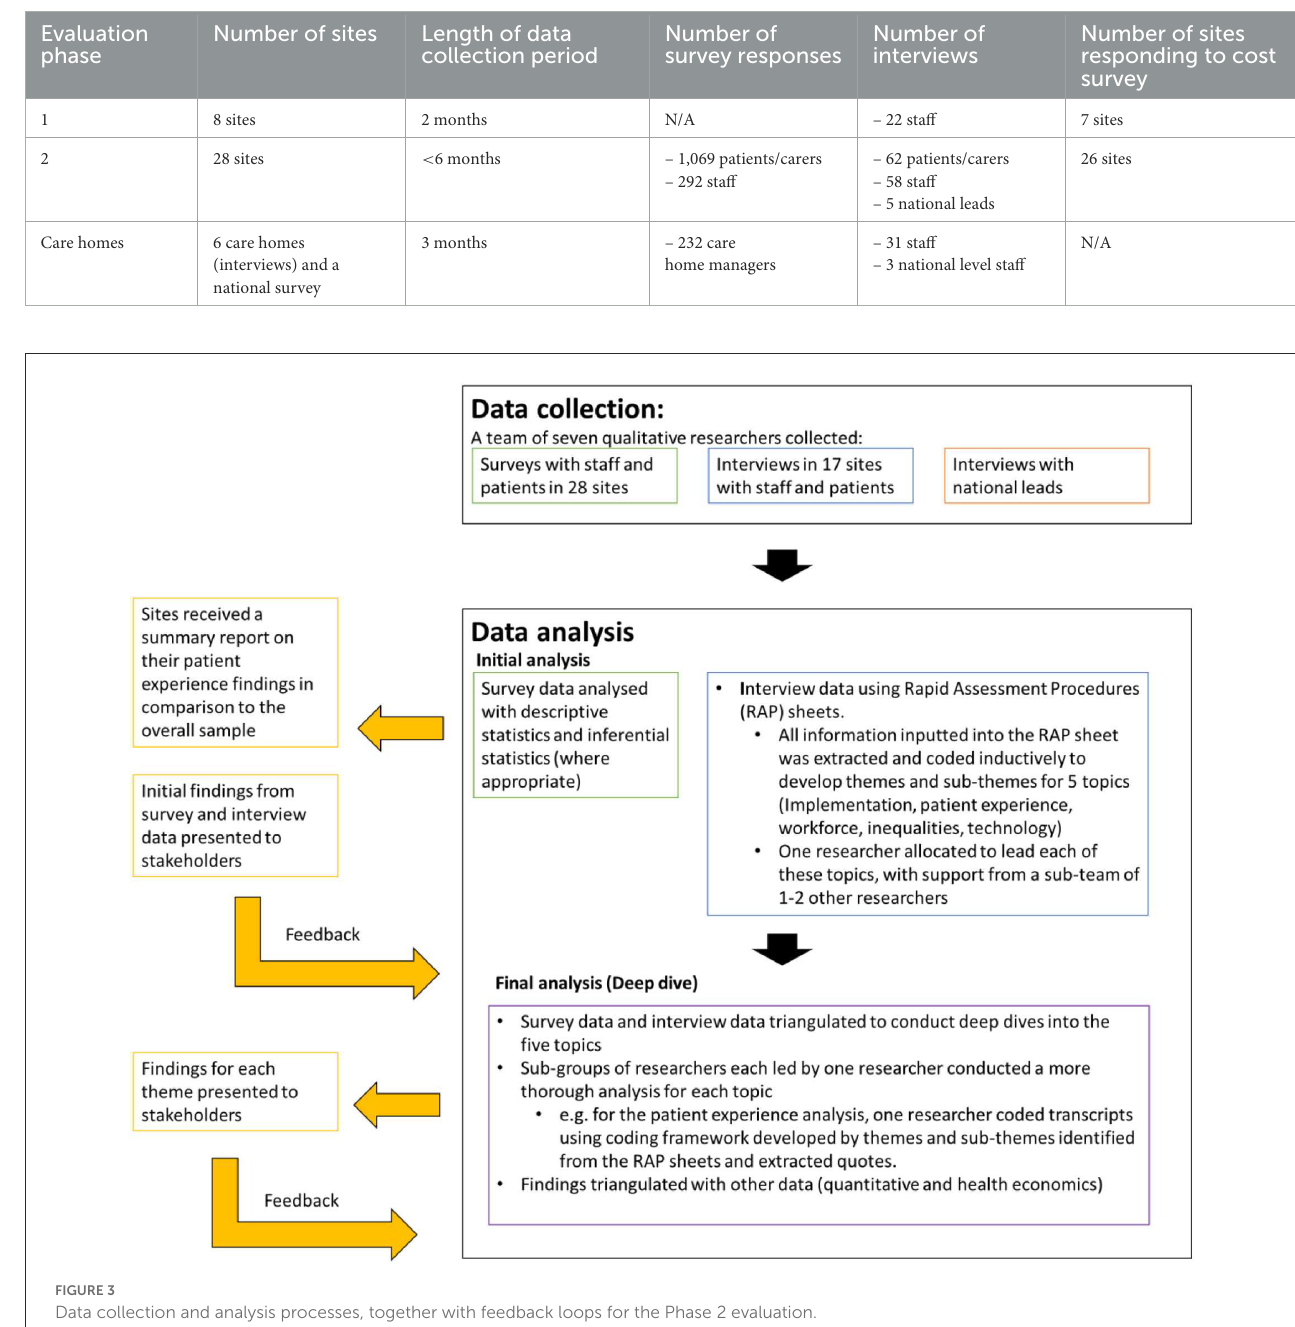
TABLE 2 Summary of primary data collected across the three evaluations.